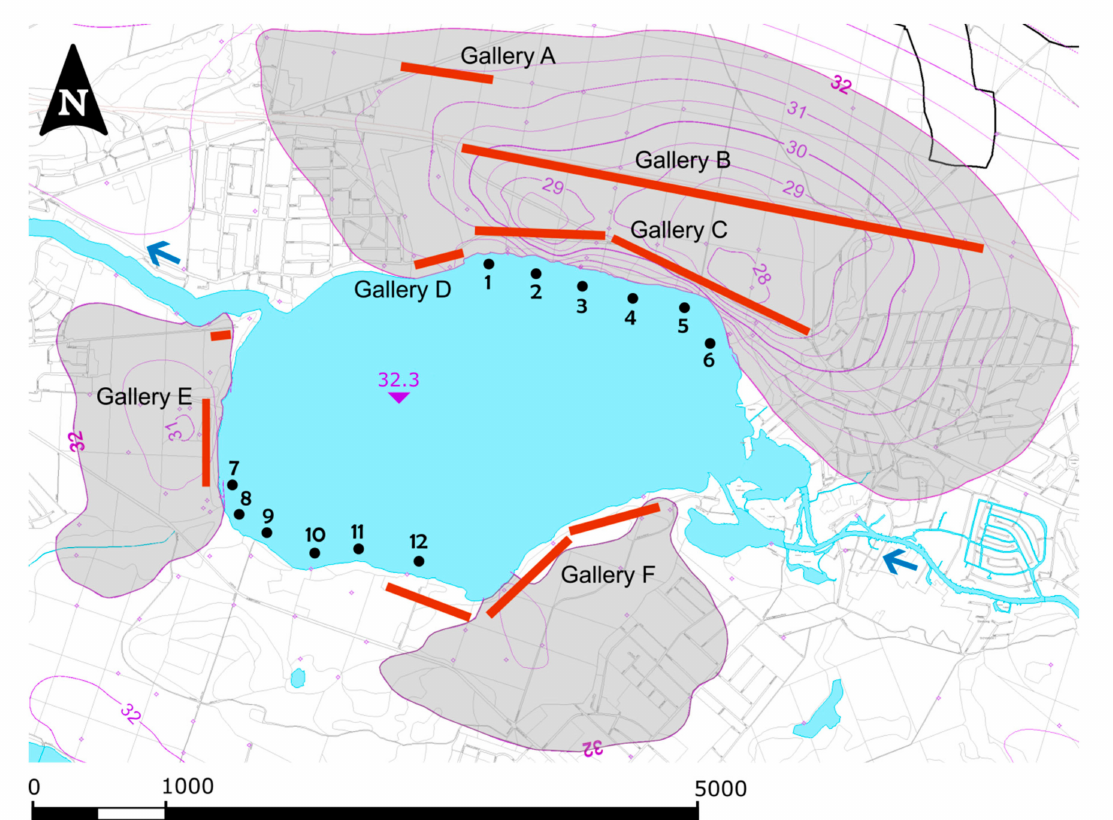
Figure 1. Sediment sample sites in Lake Müggelsee (numbered dots). Shaded area on land indicate where groundwater level is below 32 m above sea level (Lake Müggelsee = 32.3 MASL, purple: groundwater isolines), red thick lines indicate location of groundwater well